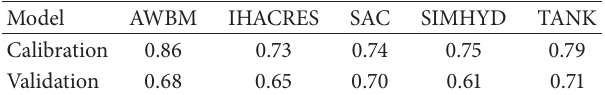
Table 2: Statistical evaluation of the model performance. Model